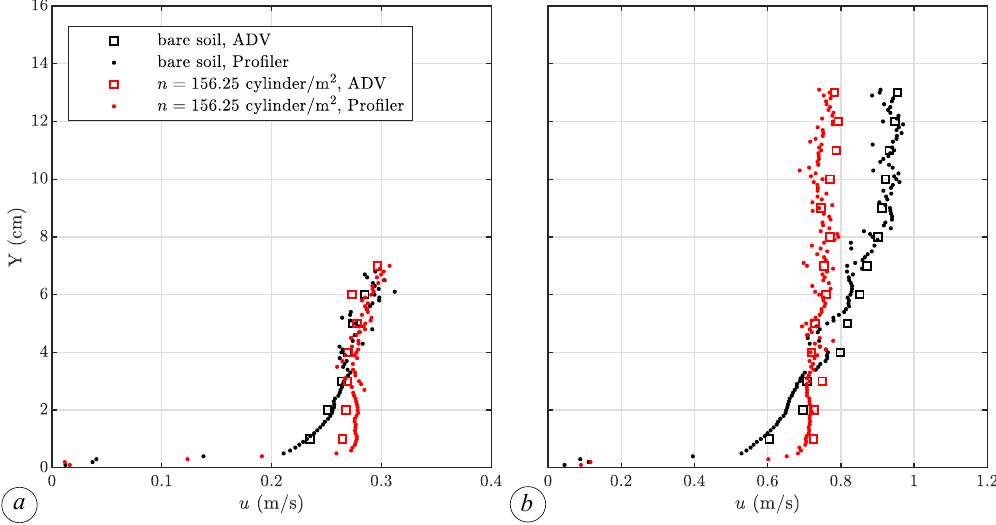
Figure 7. Vertical profile of the longitudinal velocity component u at x = 9.00 m on the channel axis, in bare soil conditions (black markers) and with vegetation (red markers), during base flow conditions ( a ) and at the wave peak ( b ). Small dots denote the ADV Profiler output, and squares denote ADV